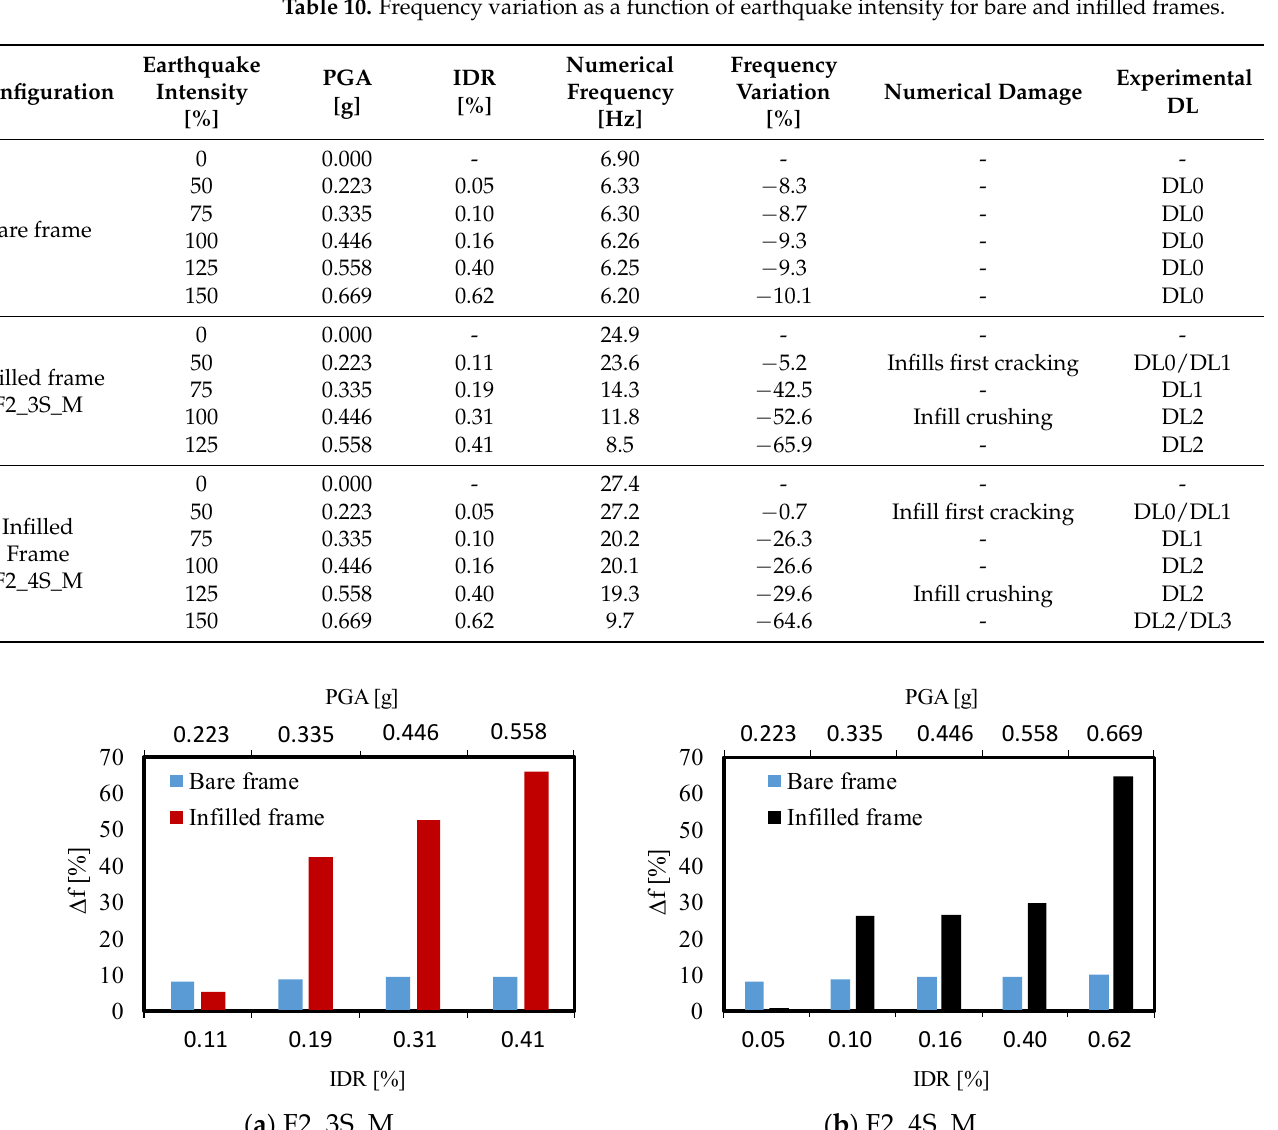
Table 10. Frequency variation as a function of earthquake intensity for bare and infilled frames.